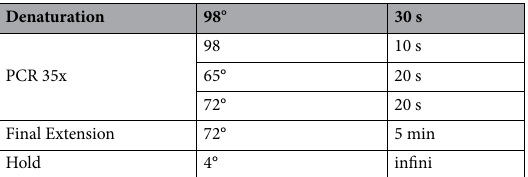
Figure 5. Loss of rgs4 function alters Akt signaling in neural cells. ( A , B ) Immunoblotting of lysates from zebrafish embryos at 20 hpf. Akt and p-Akt amounts were normalized to α-tubulin and the ratio of p-Akt relative to Akt was compared between WT and MZrgs4 lysates. No significant difference was observed between the two groups. Erk and p-Erk amounts were normalized to α-tubulin and the ratio of p-Erk relative to Erk was compared between WT and MZrgs4 lysates. No significant difference was observed between the two groups. ( C ) Immunoblotting of lysates from zebrafish embryos at 48 hpf. Akt and p-Akt amounts were normalized to β-actin and the ratio of p-Akt relative to Akt was compared between WT and MZrgs4 lysates. MZrgs4 embryos showed a significant decrease in the amount of p-Akt/Akt in comparison to WT. ( D ) Immunoblotting of lysates from zebrafish embryos at 48 hpf. Erk and p-Erk amounts were normalized to Gapdh and the ratio of p-Erk relative to Erk was compared between WT and MZrgs4 lysates. No significant difference was observed between the two groups. ( E ) Immunoblotting of neural lysates (or extracts) from zebrafish embryos at 48 hpf. Akt and p-Akt amounts were normalized to β-actin and the ratio of p-Akt relative to Akt was compared between WT and MZrgs4 lysates. MZrgs4 embryos showed a significant decrease in the amount of p-Akt/Akt in comparison to WT.